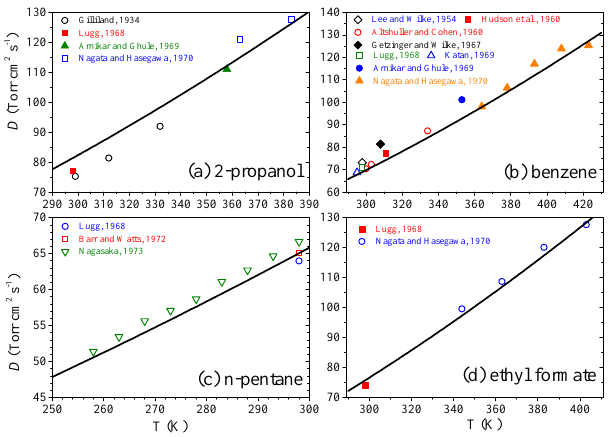
Figure 1. Comparison of measured diffusivities with estimated val- ues (black curves) as a function of temperature using Fuller’s semi- empirical method. (a) 2-propanol; (b) benzene; (c) n -pentane; and (d) ethyl